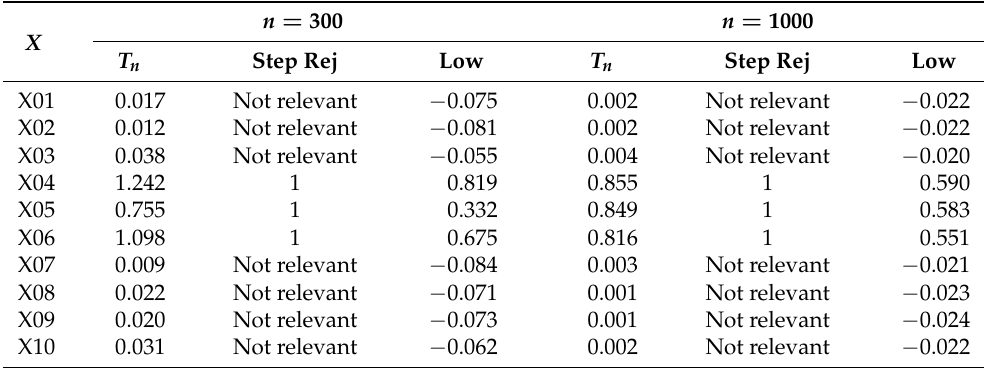
Table 3. Model M2 (De Vleaux), Test statistic T n , k -FWE rejection step (Step Rej), lower limits of the bootstrap confidence region (Low = T n − ˆ c ( 1 − α , k ) ) with B = 1999 replicates and nominal level 1 − α = 0.90, for n = 300, and n = 1000 observations.